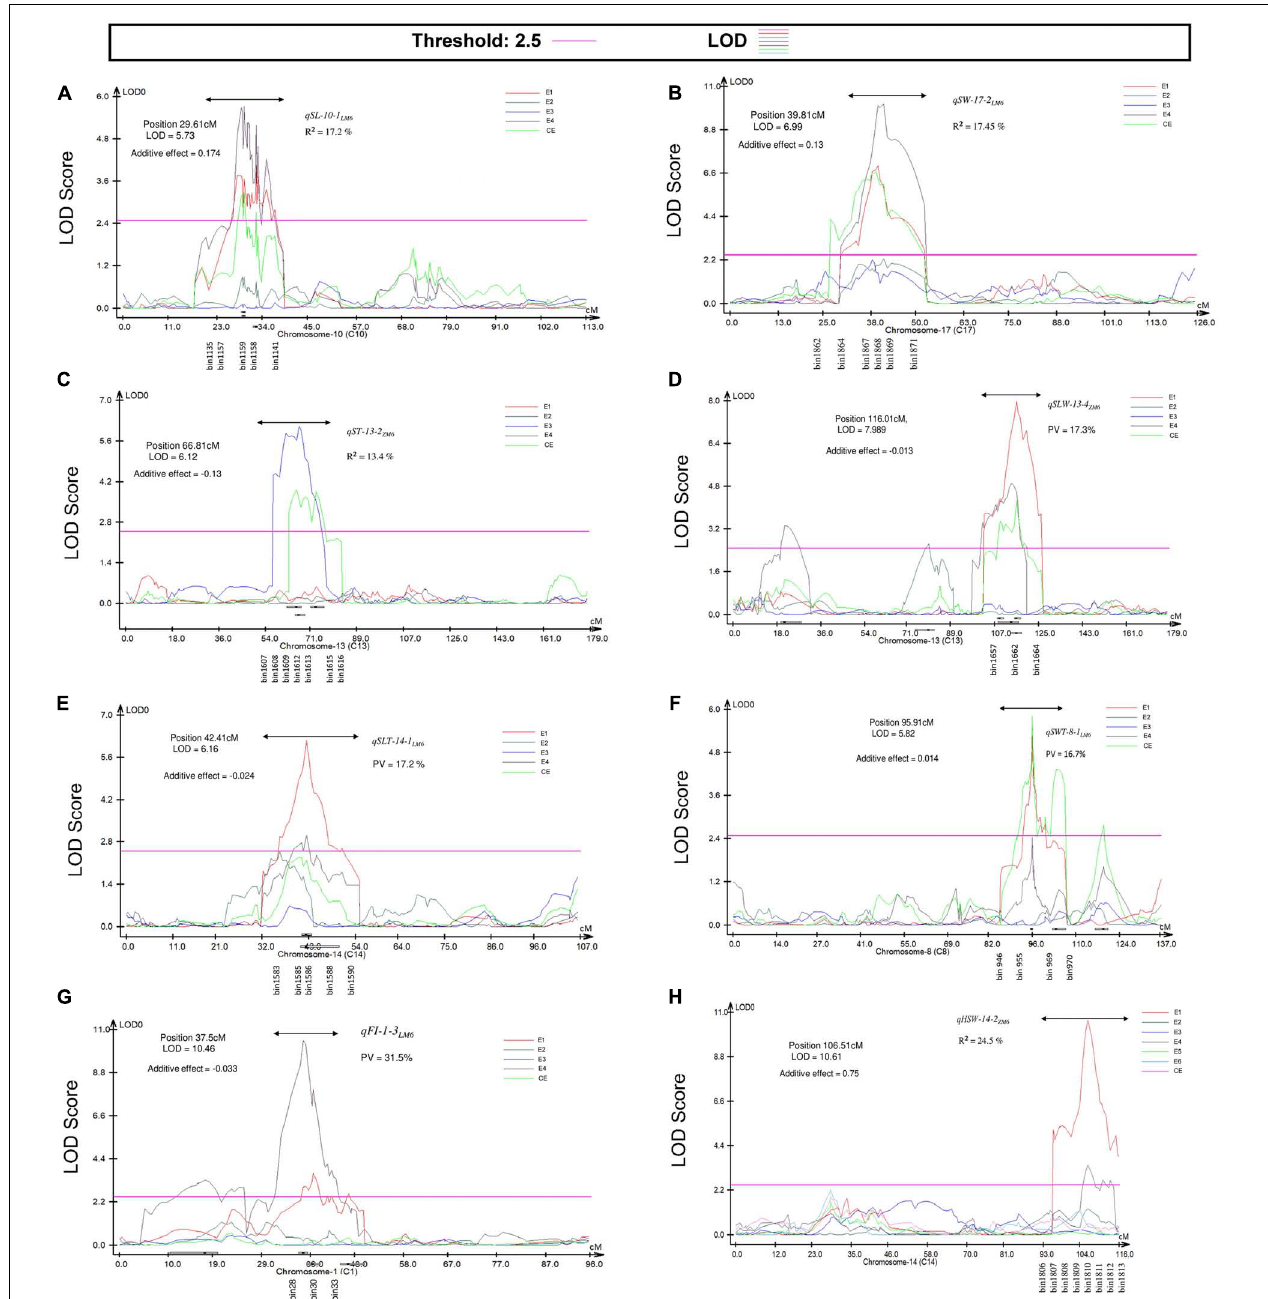
FIGURE 5 | Position of the most prominent QTL detected by the CIM approach associated with seed size and seed shape traits in the LM6 and ZM6 RIL populations grown in multiple environments indicated as with E1, FY2012; E2, JP2012; E3, JP2013; E4, JP2014; E5, YC2014; E6, JP2017, respectively, in addition to the combined environment (CE). (A) LOD curve for qSL-10-1 LM 6 , (B) LOD curve for qSW-17-2 LM 6 , (C) LOD curve for qST-13-2 ZM 6 , (D) LOD curve for qSLW-13-4 ZM 6 , (E) LOD curve for qSLT-14-1 LM 6 , (F) LOD curve for qSWT-8-1 LM 6 , (G) LOD curve for qFI-1-3 LM 6 , and (H) LOD curve for qHSW-14-2 ZM 6 . The LOD threshold (2.5) is indicated by a pink line. The double-headed arrow denotes the location of prominent QTL. The X and Y -axes represent chromosome and LOD score, respectively.